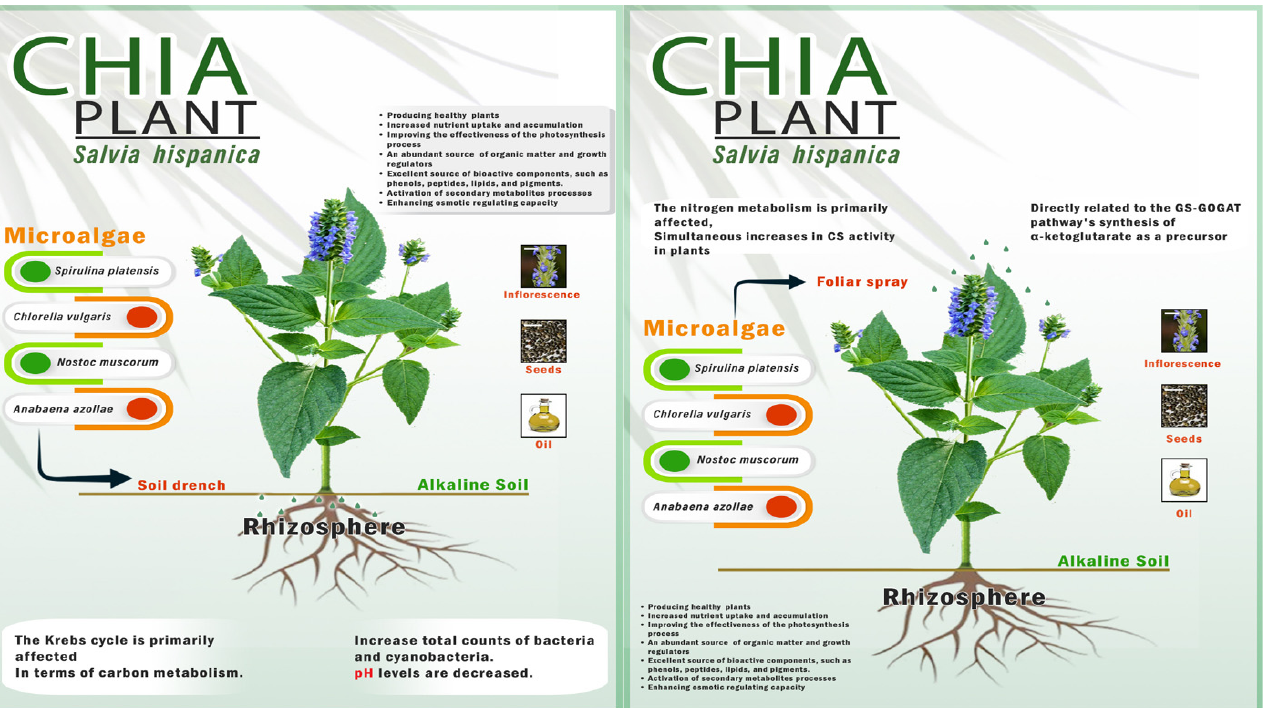
Figure 3. The mechanisms of foliar spray and soil drenching with microalgae supplementation on chia plants cultivated under alkaline stress